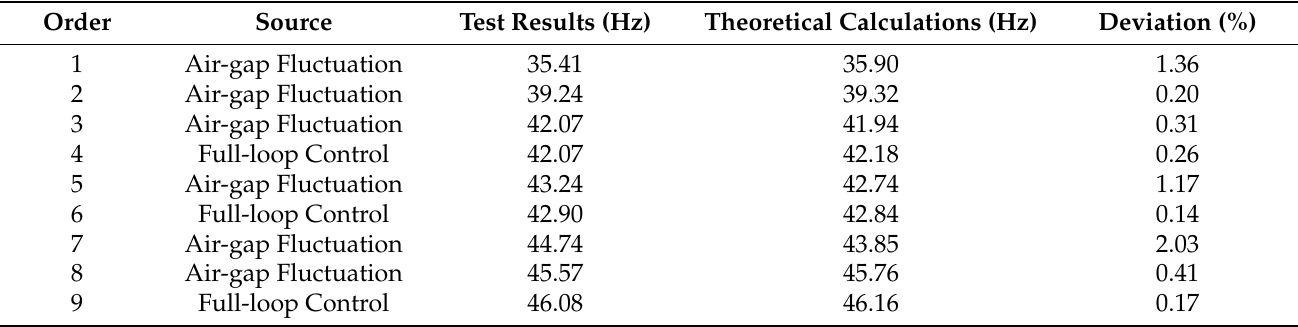
Table 4. The coupling thrust force caused by the first-order cutting force.